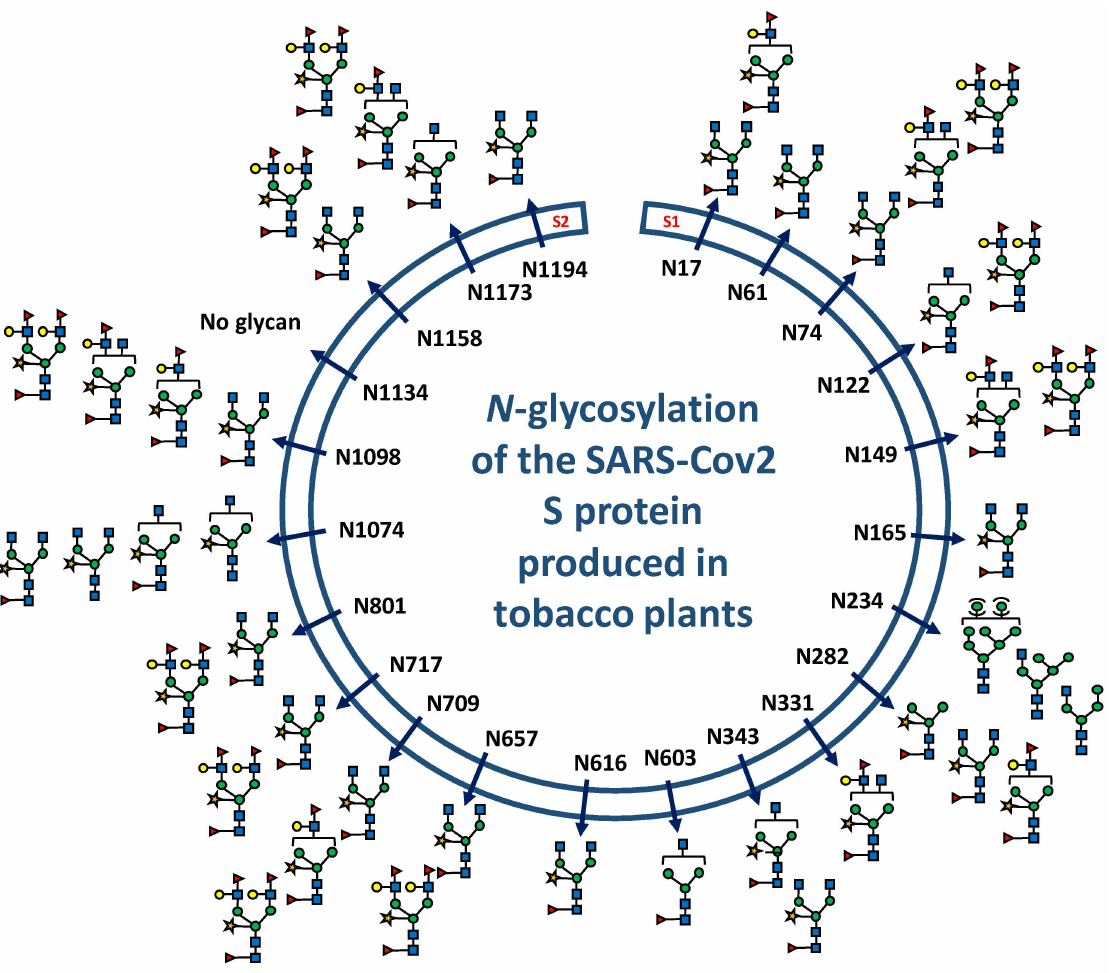
Figure 4. Distribution of main N -glycans on the 22 N -glycosylation consensus sites of the SARS-CoV-2 S protein produced in plants. Distribution of all N -glycans per glycosite are reported in Table S1. Blue square: GlcNAc; green circle: Man; red triangle: Fuc; yellow circle: Gal and yellow star: